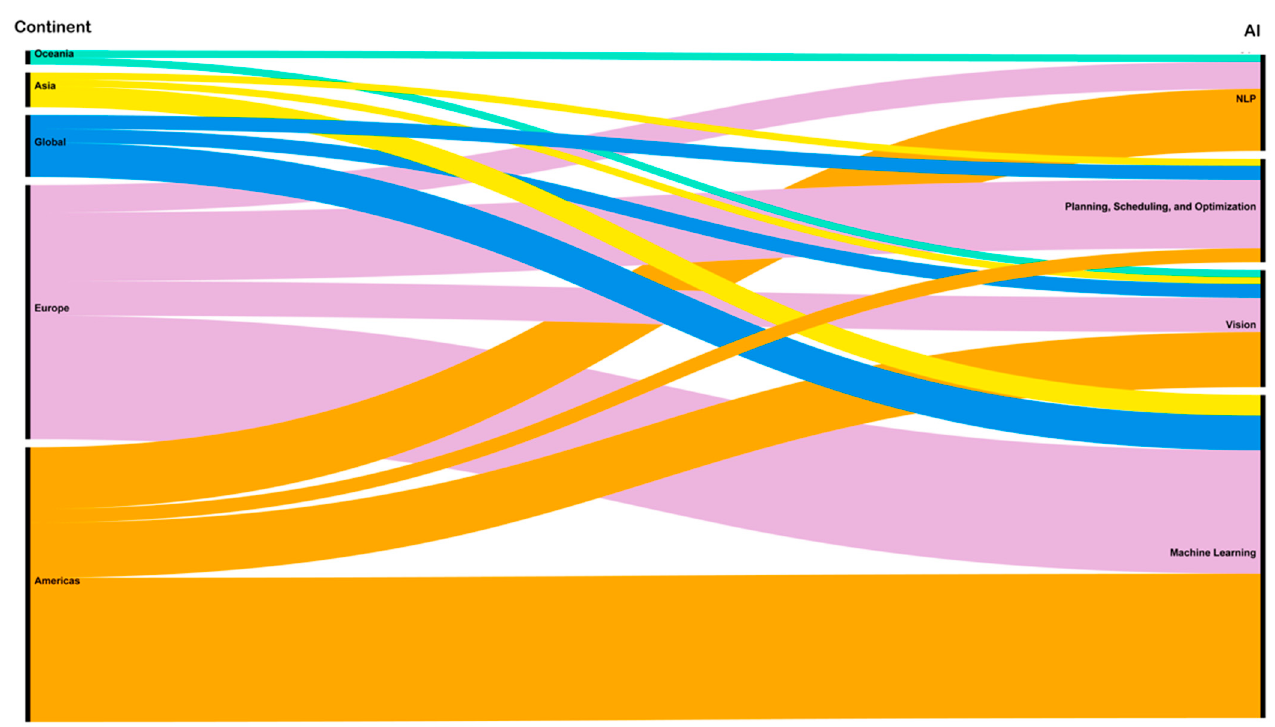
Figure 3. Fields of AI in relation to the continents (Source: Authors).